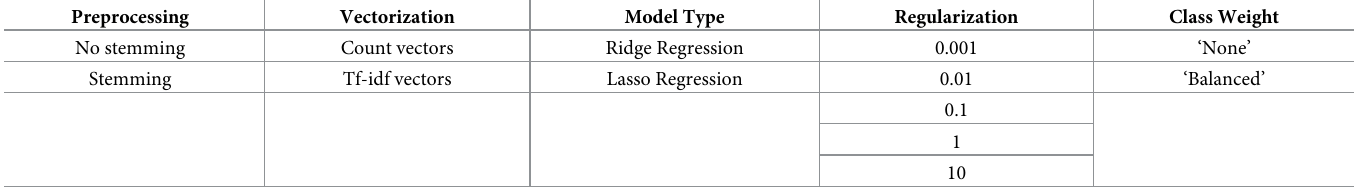
Table 2. All possible options for each step of the machine learning pipeline. All possible combinations of these options were trained for each target specialty (for a total of 80 models per specialty).